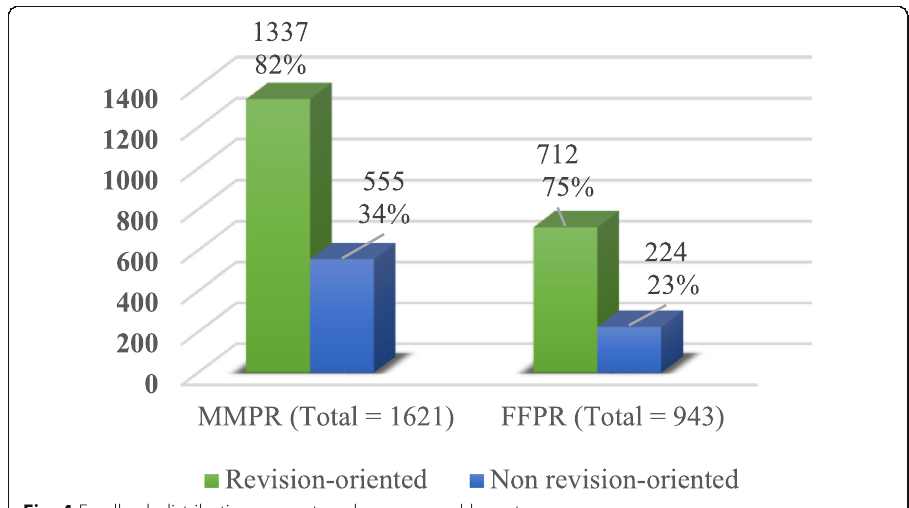
Fig. 4 Feedback distribution percentage by group and by nature